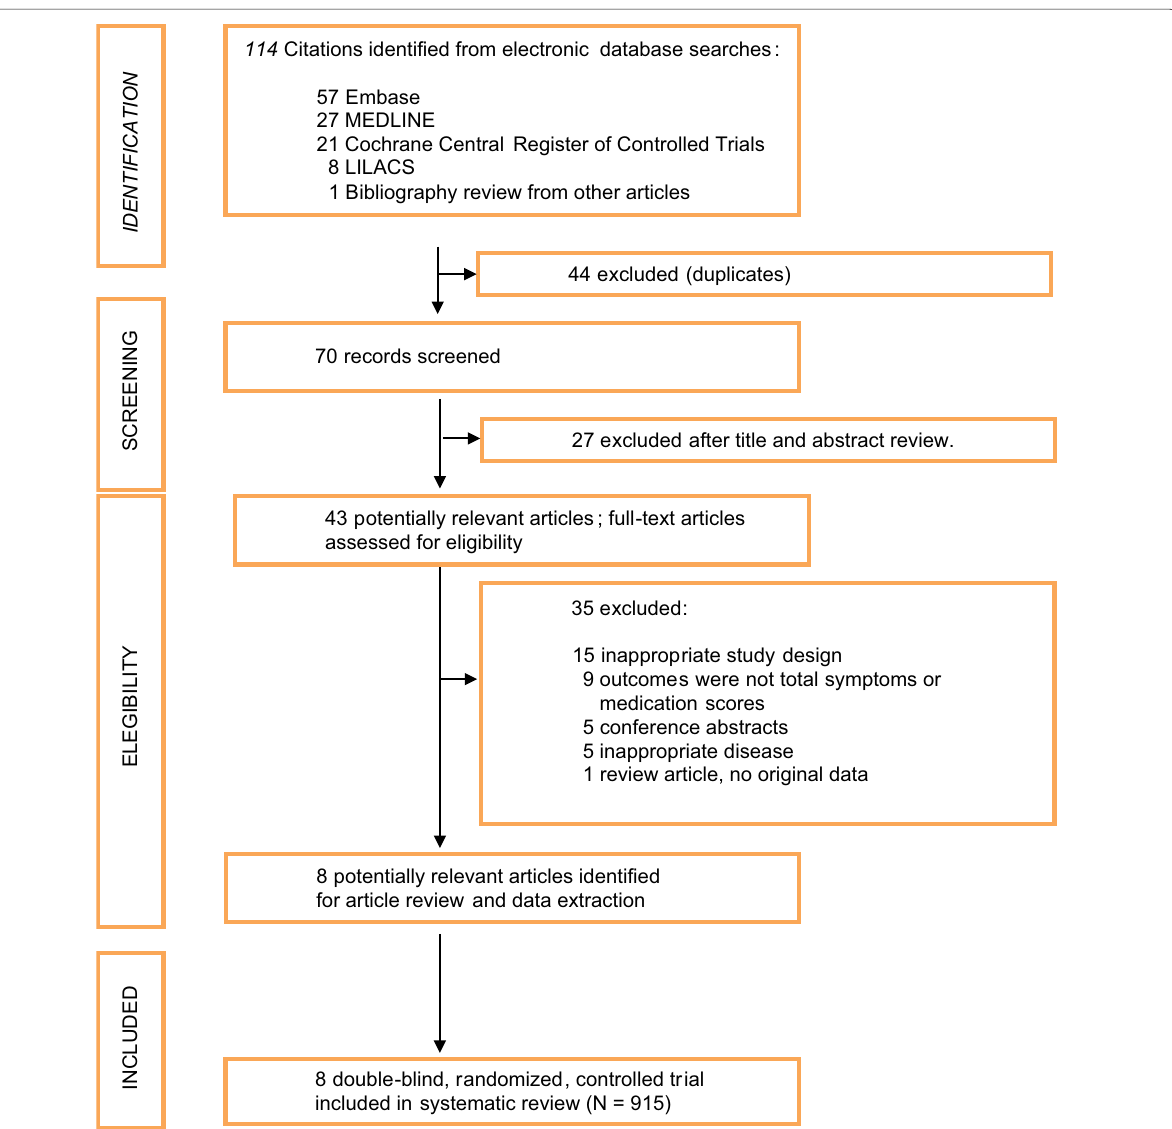
Fig. 1 Flow Diagram of depigmented polymerized immunotherapy studies selection. Data recorded by two researchers were compared. When no agreement was found in a particular issue, the original paper was reanalyzed until a consensus decision was reached. Studies published as continuations of previously published studies were excluded to prevent repetition of